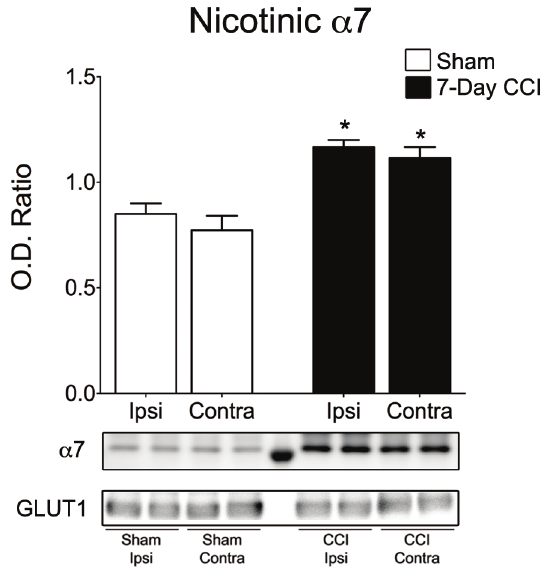
Figure 8. Surface expression of a 7 subunit of neuronal nicotinic acetylcholine receptor is increased in the BLA of CCI animals 7-days after mild CCI. Western blot was performed using biotinylated proteins isolated from the ipsilateral and contralateral sides of Sham and CCI 7-day animals. Group data showing the mean 6 SE of the ratio between the a 7 subunit and GLUT1 optical densities. Top panel: representative Western blot for a 7 -nAChRs. Bottom panel: representative Western blot for GLUT1, used as a loading control. * p , 0.05; n=4 for each group.